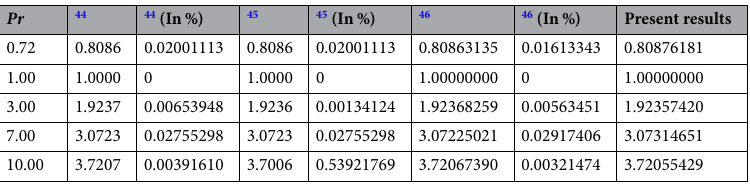
Table 2. Comparative variation of